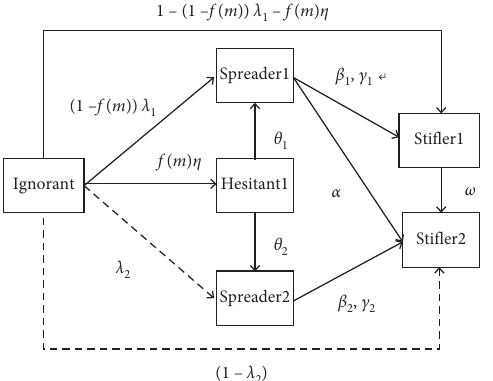
Figure 1: 2SIH2R rumor spreading